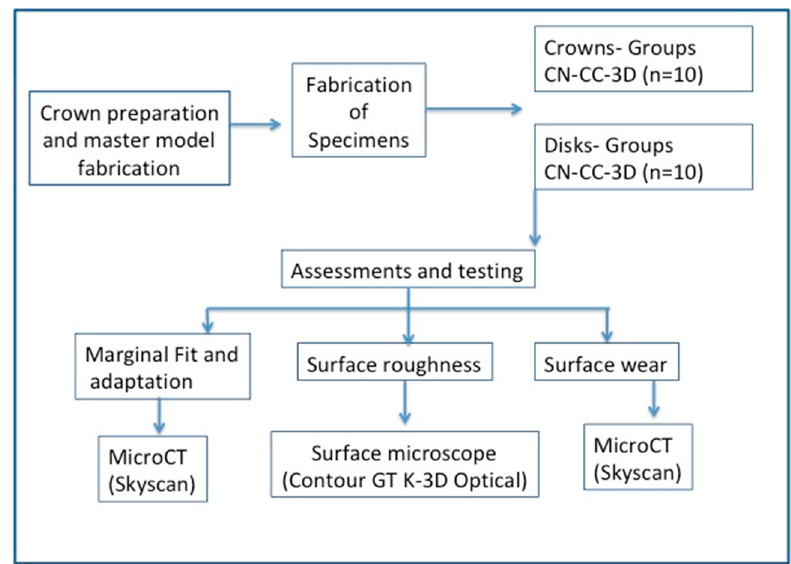
Figure 1. Brief study methodology.